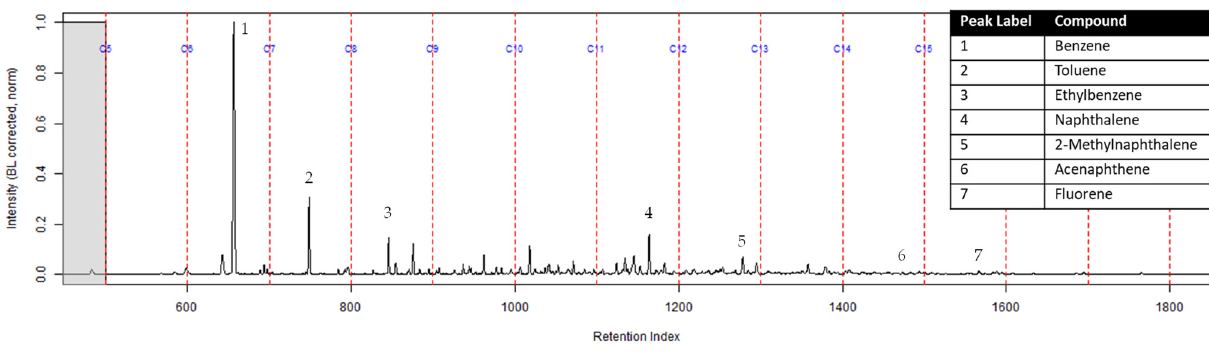
Figure 4. Zoomed TIC of the extract from the suspended activated charcoal strip from a can containing 2-min MDDM burned vinyl siding and a railroad tie (maximum peak abundance 1.8 × 10 7 ). This charcoal strip was not in a dosimeter.